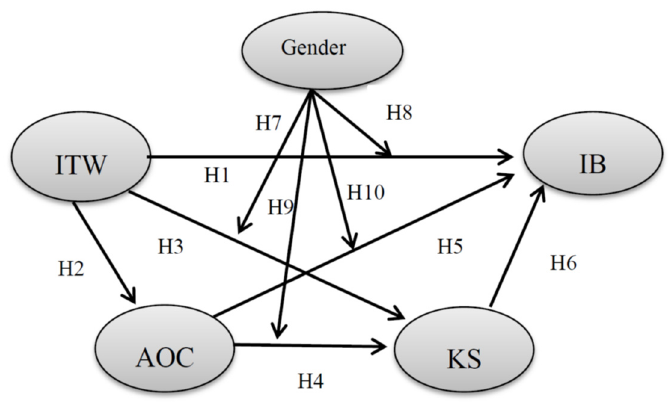
Figure 1. The hypothesized model. Notes: ITW = interpersonal trust in the workplace; AOC = af- fective organizational commitment; KS = knowledge sharing; IB = innovation behavior.